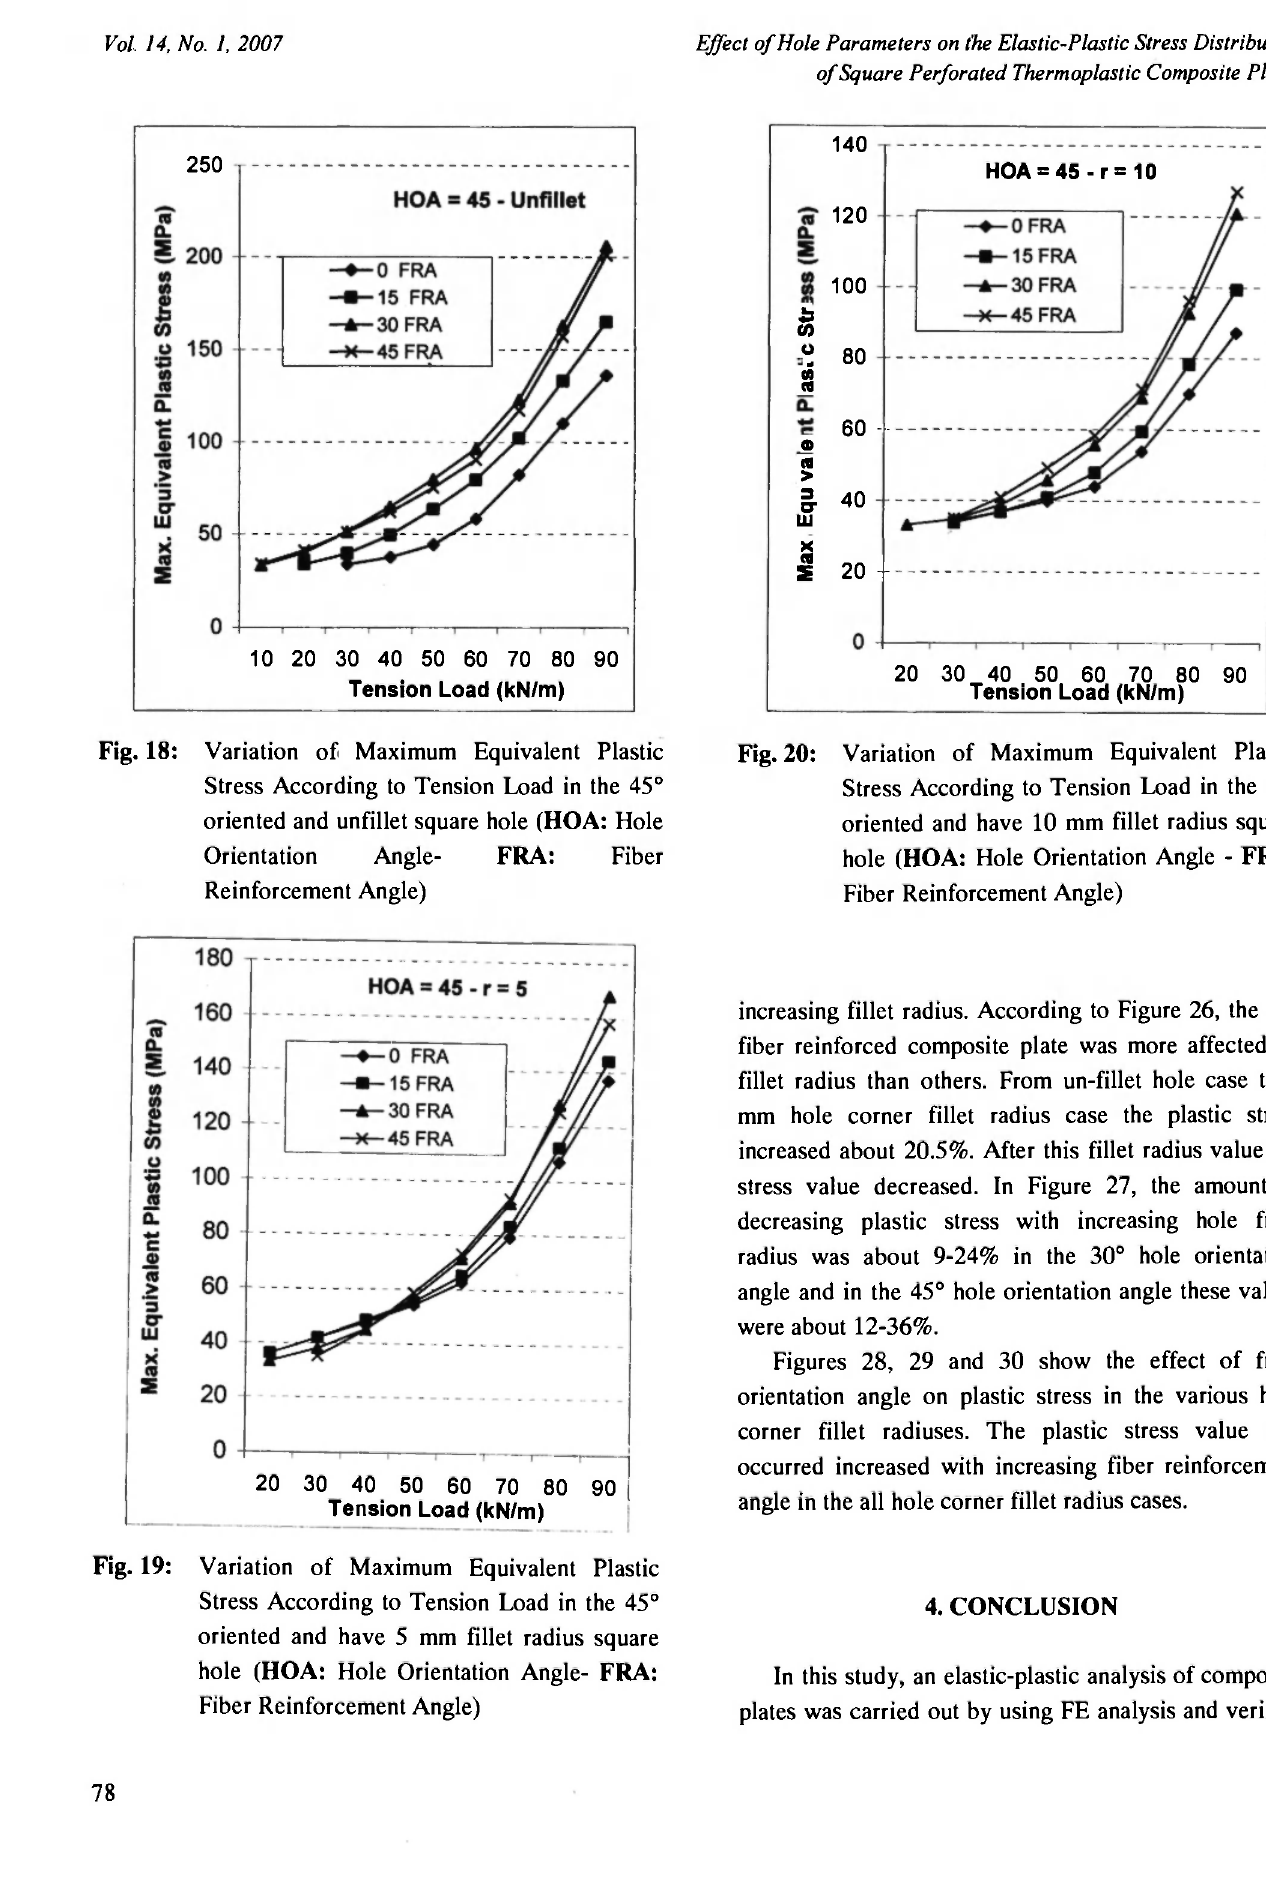
Fig. 19: Variation of Maximum Equivalent Plastic Stress According to Tension Load in the 45° oriented and have 5 mm fillet radius square hole (HOA: Hole Orientation Angle- FRA: Fiber Reinforcement Angle)